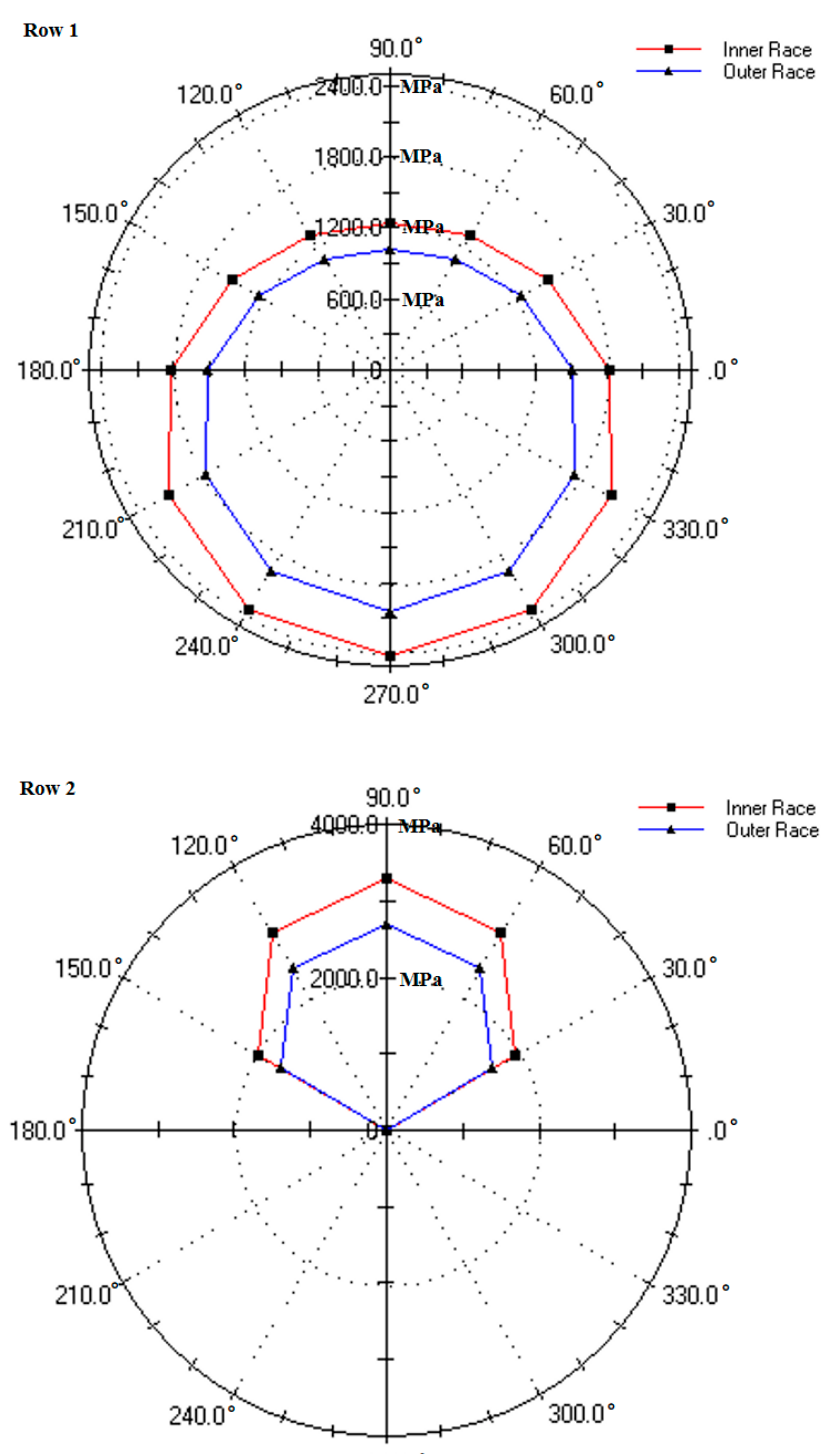
Figure 14. Bearing contact stress of hub bearing under test load condition.